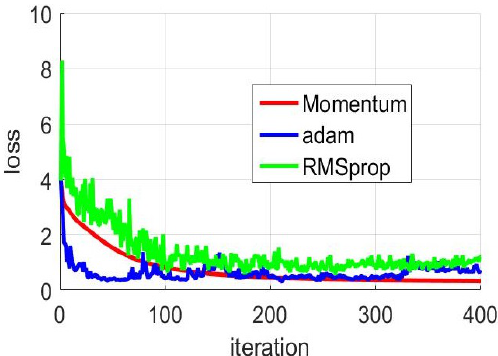
Figure 13. Localization precision with different optimization